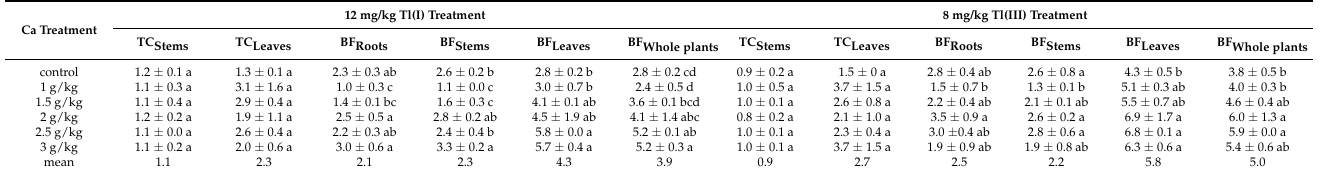
Table 5. Transfer coefficient (TC) 1 , bioconcentration factor (BF) 2 for green cabbage with 12